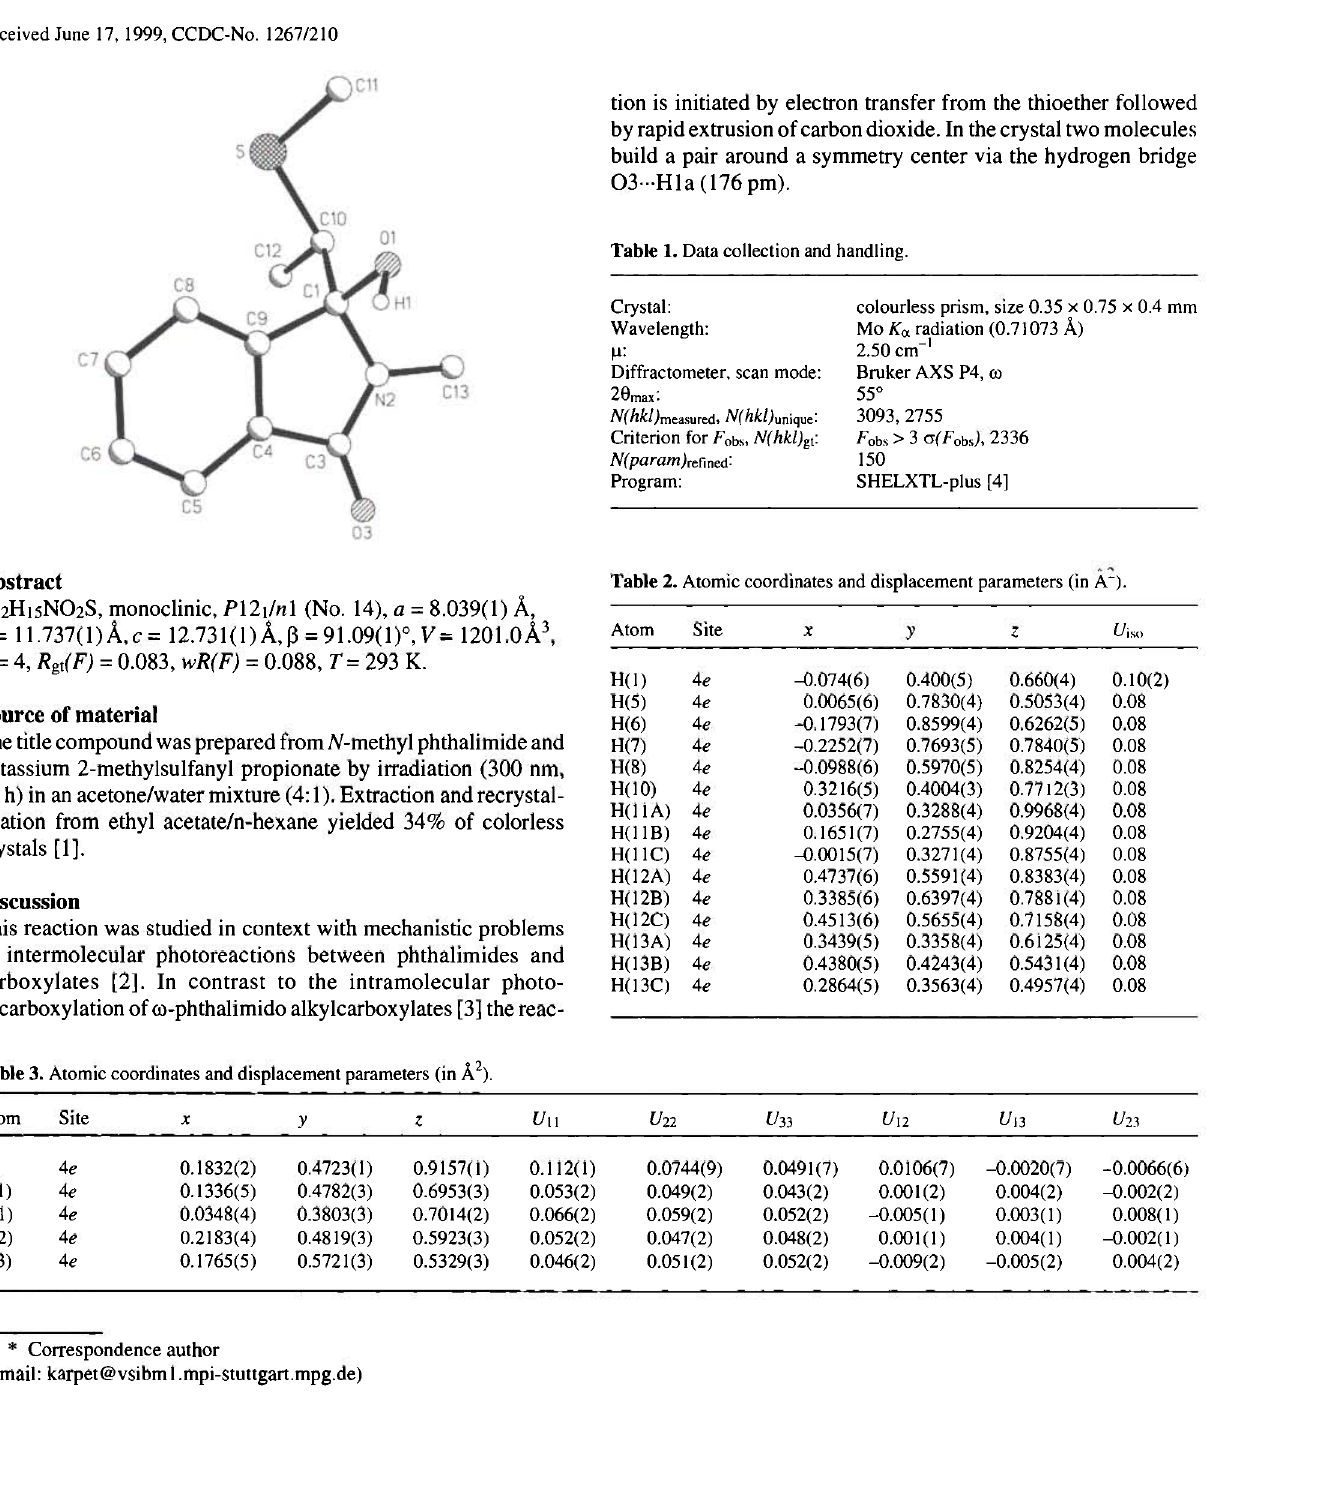
Table 1. Data collection and handling.